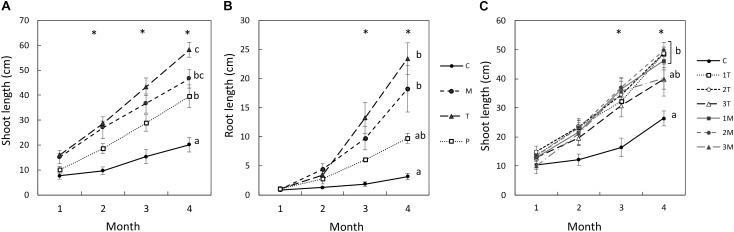
Averages and standard errors of shoot length (A) and root length (B) of plants throughout the rhizobox experiment, and shoot length in the pot experiment (B). ∗ indicates p < 0.005 in the ANOVA analysis. Different letters indicate significant differences in total root length between treatments (p < 0.05, Turkey’s test), n = 3 in (A,B), except for T in (B), with n = 2, and n = 5 in (C).